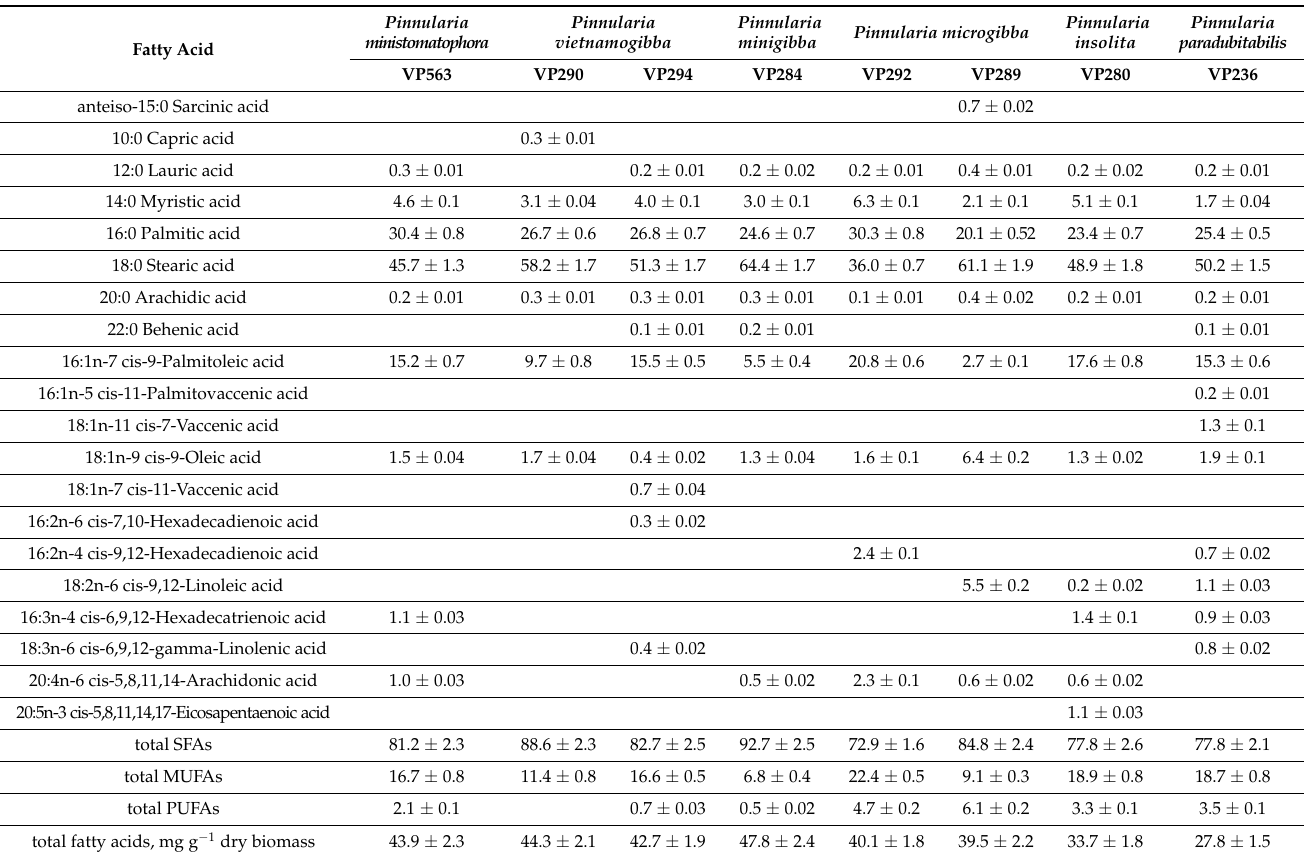
Table 3. Fatty acid composition of new Pinnularia strains, the data are reported as the mean (% of total fatty acids and mg g − 1 dry biomass) ± standard error from three independent biological